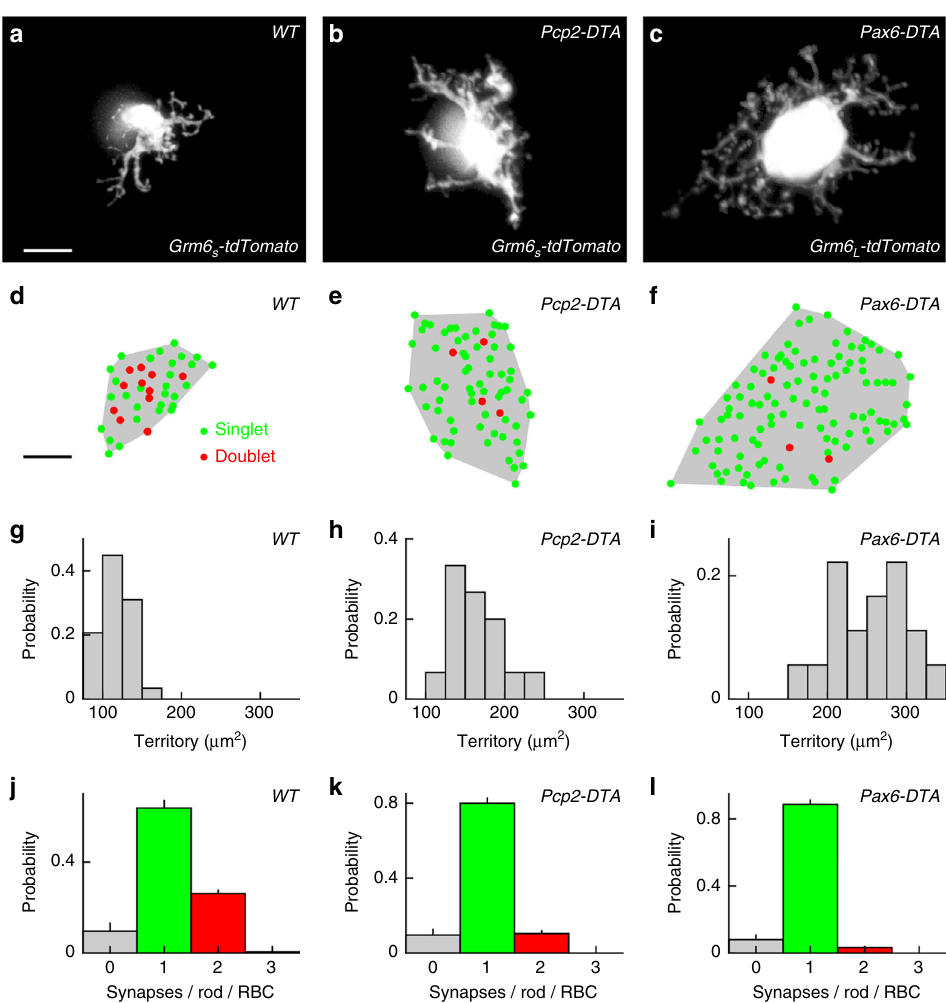
Fig. 4 Cell density regulates RBC dendrite and synapse development. a – c Maximum intensity projection of dendritic trees of individual RBCs labeled via AAVs ( Grm6 S -tdTomato ) or in a transgenic line ( Grm6 L - tdTomato ) in wild-type ( a ), Pcp2-DTA ( b ), and Pax6-DTA ( c ) mice. For visual clarity, RBCs were digitally isolated in Amira. Scale bar indicates 5 μ m. d – f Maps of dendritic territories (gray shaded areas) and synapse con fi gurations (singlets: green circles, doublets: red circles) of the cells shown in a – c . Scale bar indicates 5 μ m. g – i Summary data of RBC dendritic territories in wild-type ( g , n = 29 RBCs, n = 8 mice), Pcp2-DTA ( h , n = 15 RBCs, n = 6 mice), and Pax6-DTA ( i , n = 18 RBCs, n = 6 mice) mice. By Kruskal – Wallis one-way ANOVA testing, RBC dendrite territories in Pcp2-DTA and Pax6-DTA retinas were larger than in wild-type retinas ( p < 0.005 and p < 10 − 8 , respectively), and RBC dendrite territories were larger in Pax6-DTA than in Pcp2-DTA retinas ( p < 0.02). j – l Population data (mean ± SEM) of the distribution of synapses con fi gurations on RBC dendrites in wild-type ( j , n = 29 RBCs, n = 8 mice), Pcp2-DTA ( k , n = 15 RBCs, n = 6 mice), and Pax6-DTA ( l , n = 10 RBCs, n = 4 mice) retinas. By Kruskal – Wallis one-way ANOVA testing, the average number of PSDs per rod and RBC was lower in Pax6-DTA than in wild-type retinas ( p <